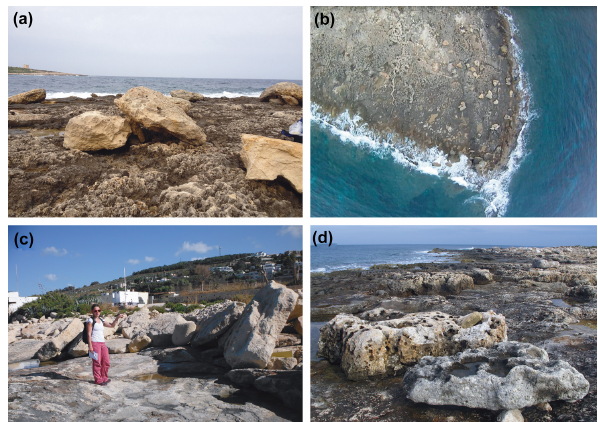
Figure 5. Splash and Fun Water Park: (a) scattered boulders belong- ing to LCL; (b) UAV view of the deposit; (c) Bahar i˙c-˙Cagharaq: boulders belonging to GLO; (d) isolated boulders at Pembroke (the underwater profiles are very similar to Fig.